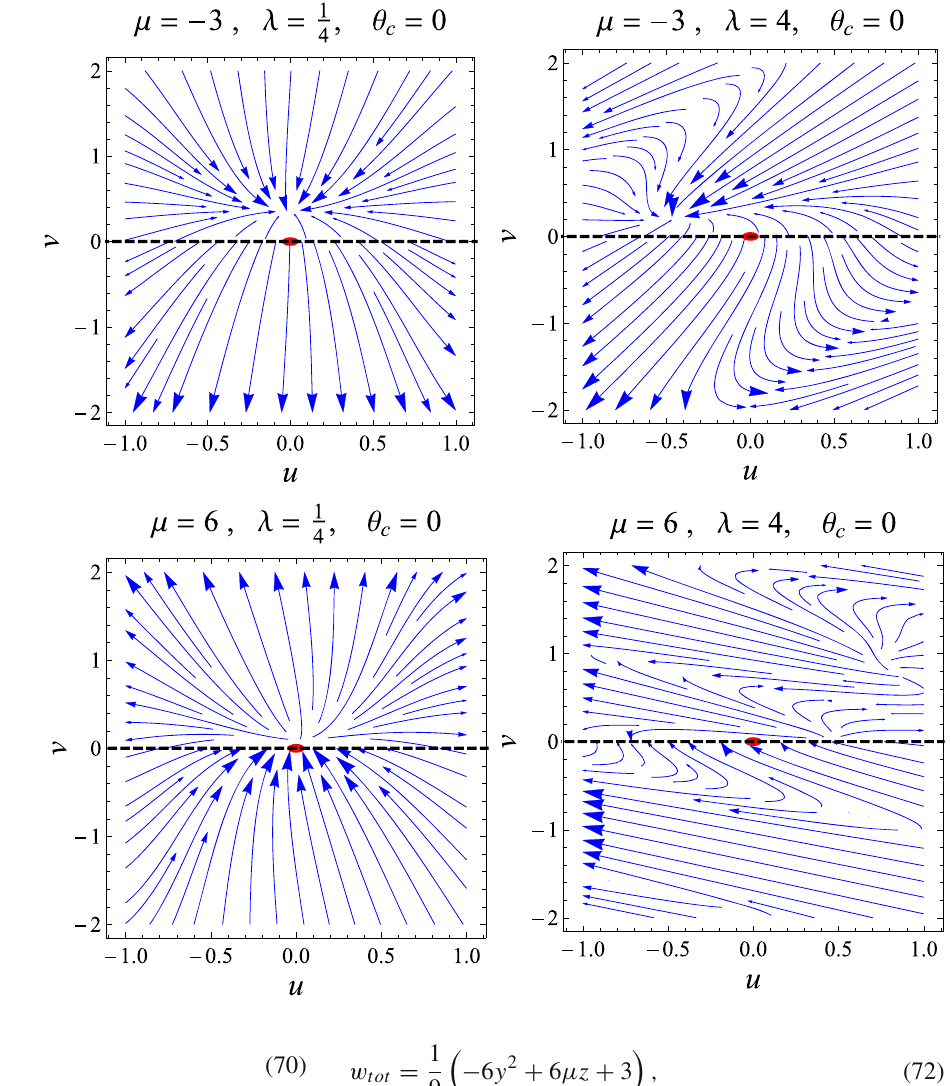
Fig. 10 Phase portrait of (65) for different values of λ,μ ad θ